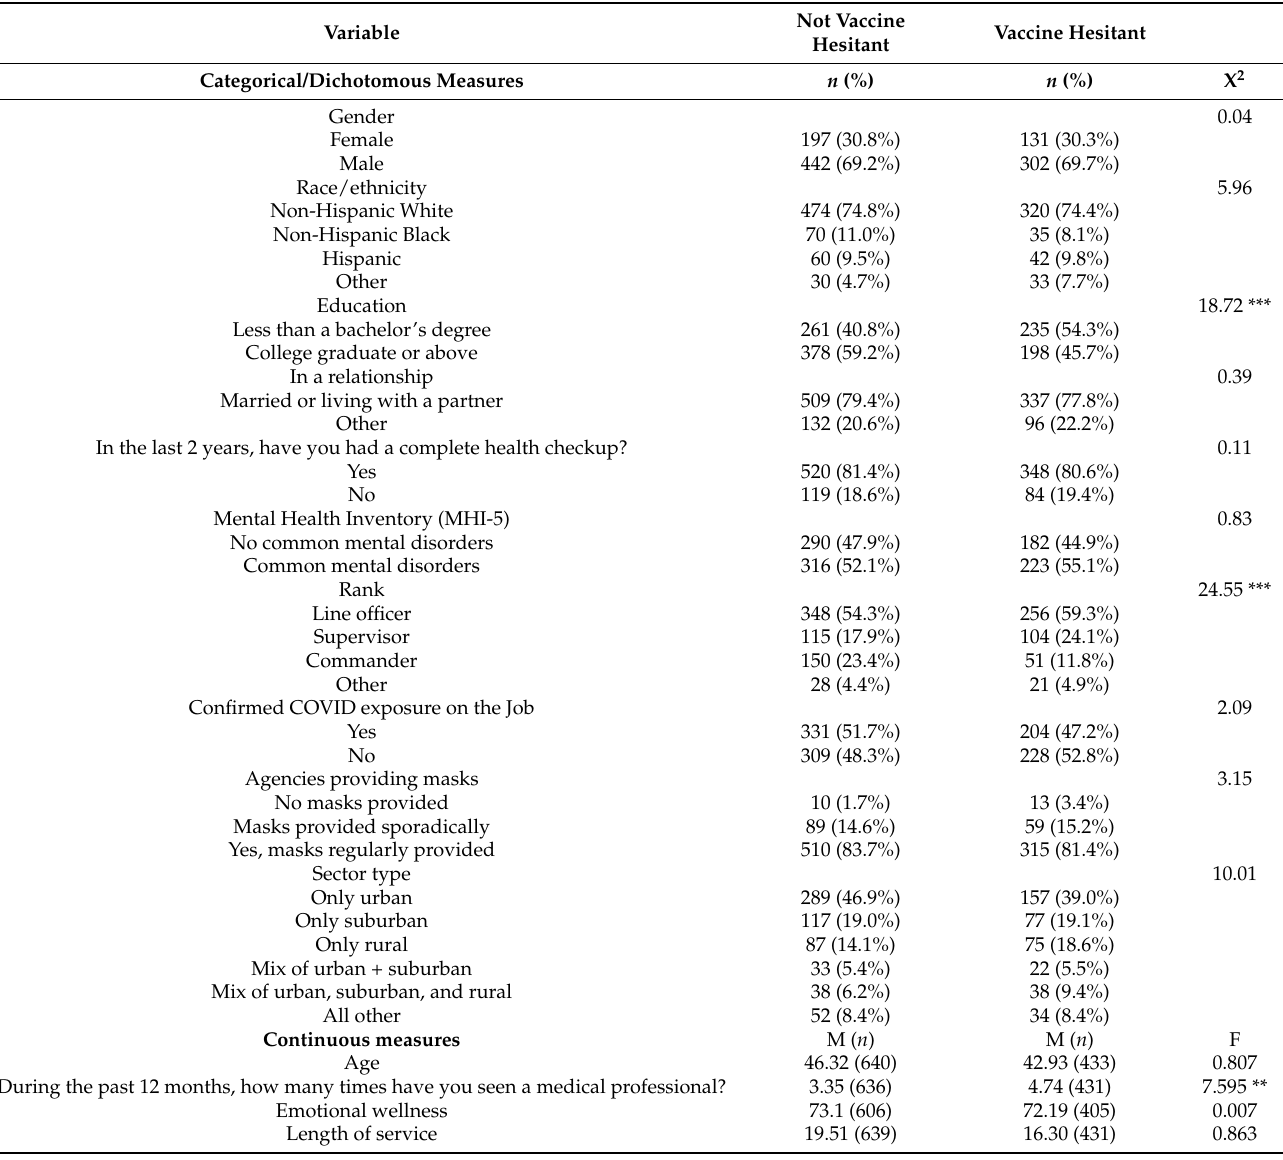
Table 2. Multinomial logistic regression for COVID-19 vaccine hesitancy ( n = 997).